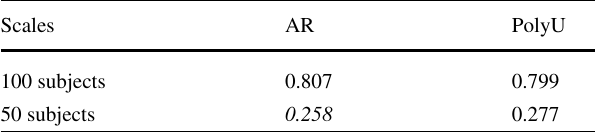
Table 7 The average running time (sec) per sample of SRC-based ver- ification with different dictionary scales when using CNN features